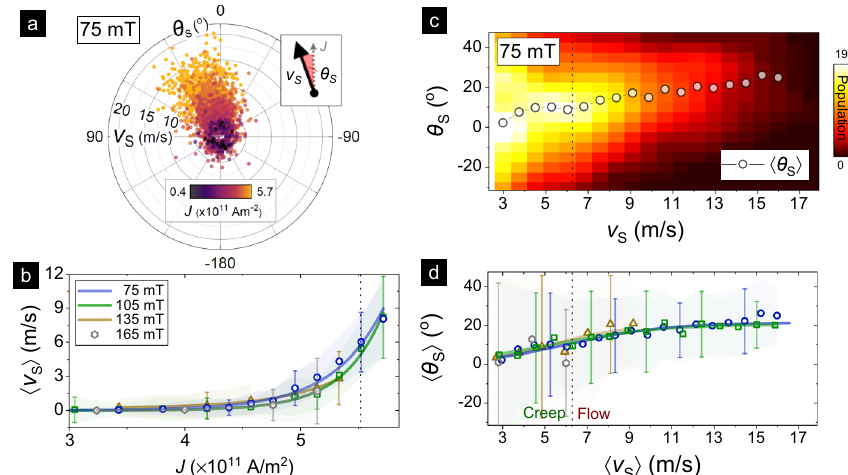
Fig. 2 Current-driven skyrmion dynamics overview. a Polar plot overview of the skyrmion motion statistics for μ 0 H ≃ 75 mT across all currents J (data for J < 0 fl ipped by 180 ∘ ), showing the spread of velocity ( v fl ection ( θ S ) and angular de S ). The data is visibly biased towards the upper left quadrant. Inset shows a schematic de fi ning v S and θ S relative to the direction of J . b Plot of the average skyrmion speed, 〈 v S 〉 , against J for various applied fi elds. Solid lines present exponential fi ts (see Methods), while shaded regions represent the standard deviation, also emphasized by error bars for selected points. The dotted line — determined from ( d ) — demarcates creep and plastic fl ow regimes. c 2D histogram color plot of skyrmion de fl ection, θ S against v S for μ 0 H ≃ 75 mT across all currents. The data were binned by v S for this plot. Solid markers show the average de fl ection, 〈 θ S 〉 , for each v S bin. d Plot of 〈 θ S 〉 against 〈 v 〉 — determined as in ( c ) — for various applied fi elds. Solid lines present sigmoidal fi ts (see Methods), while shaded regions represent the standard S i ¼ 0 : 5 h θ i sat using the fi deviation, also emphasized by error bars for selected points. Creep and plastic fl ow regimes are demarcated at h θ S S